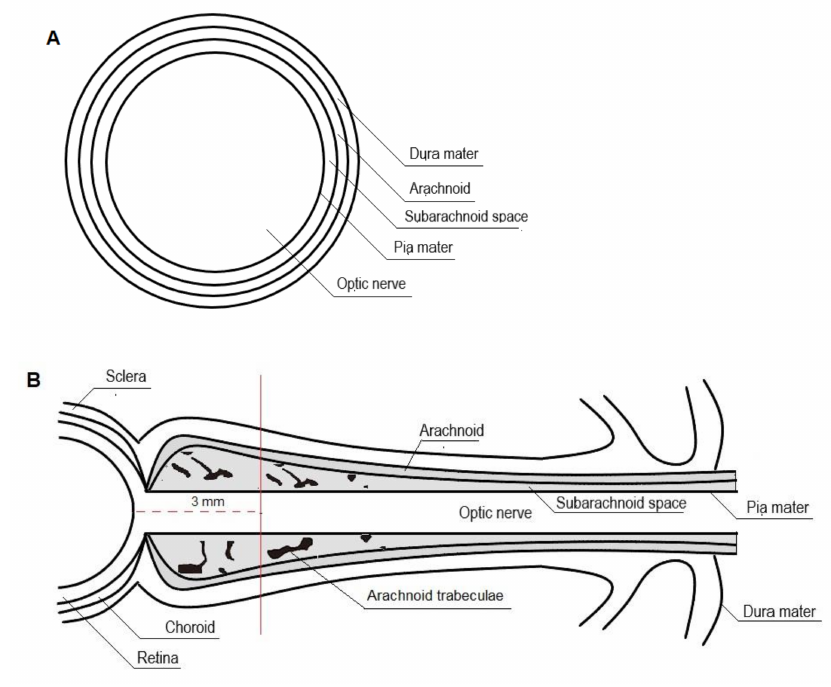
Figure 2. Cross-section ( A ) and longitudinal section ( B ) of the optic